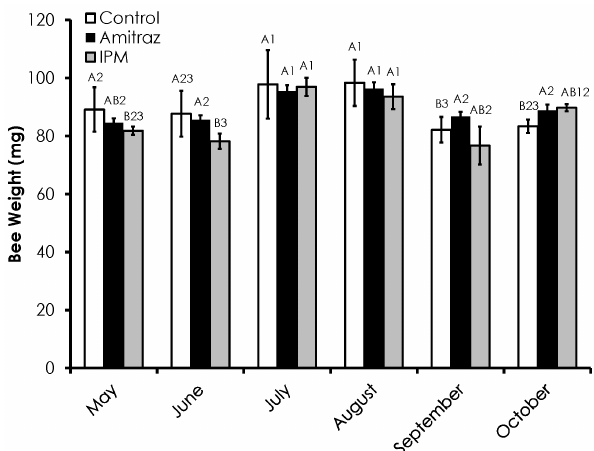
Figure 2. Adult honey bee weight over time among the Control, Amitraz, and IPM groups. Data are shown as the average ± SEM. Significant differences between and within treatment groups is as described in Figure